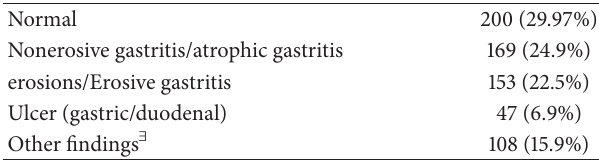
Table 3: Endoscopic findings of gastric